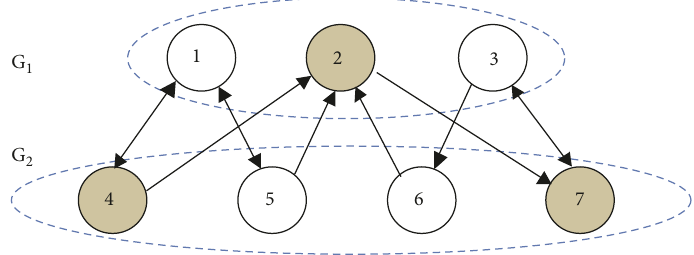
Figure 6: The directed graph topology of the heterogeneous